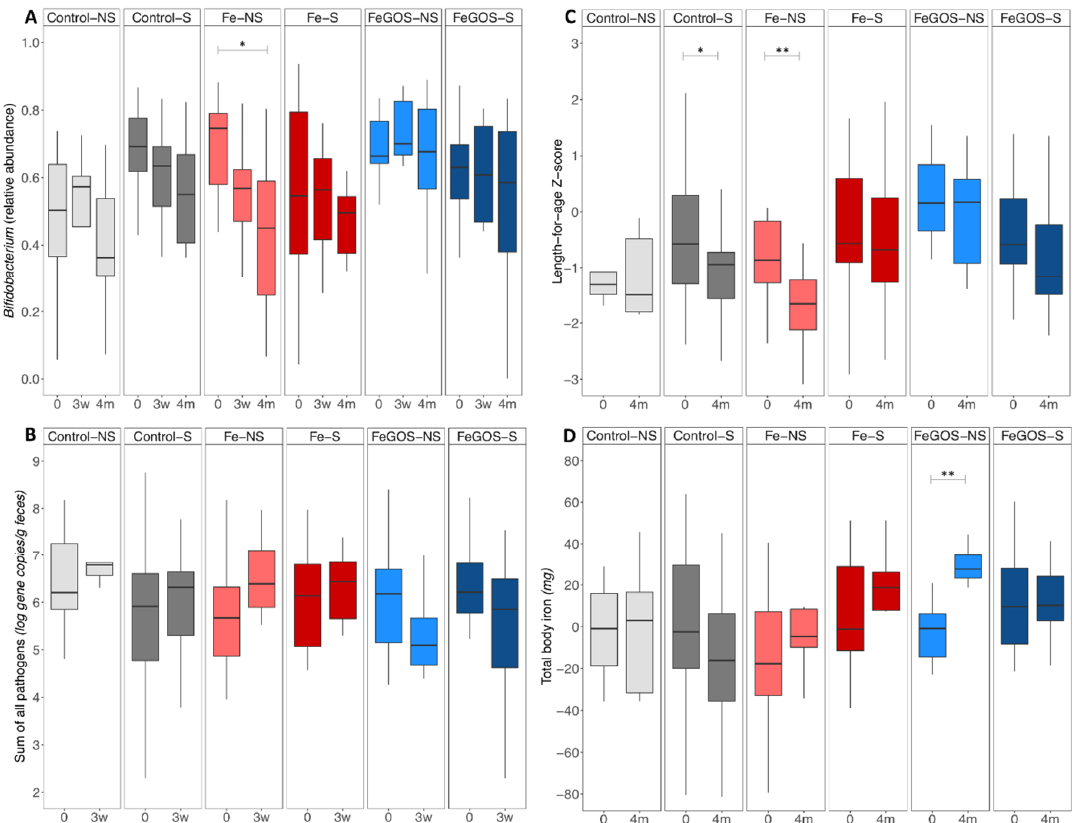
Figure 2. Relative abundances of Bifidobacterium and of the sum of virulence and toxin genes of the 10 targeted pathogens, length-for-age Z-score and total body iron, by group. Kenyan infants ( n = 75) receiving daily a micronutrient powder containing either no iron (Control–) ( n = 26), containing 5 mg of iron (Fe–) ( n = 24), or containing 5 mg of iron and 7.5 g of galacto-oligosaccharides (FeGOS–) ( n